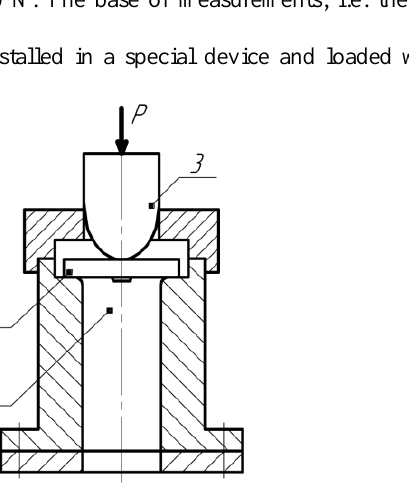
Fig. 2. Testing samples under biaxial uniform stretching: 1 – plastic sample; 2 – researched area; 3 – spherical punch